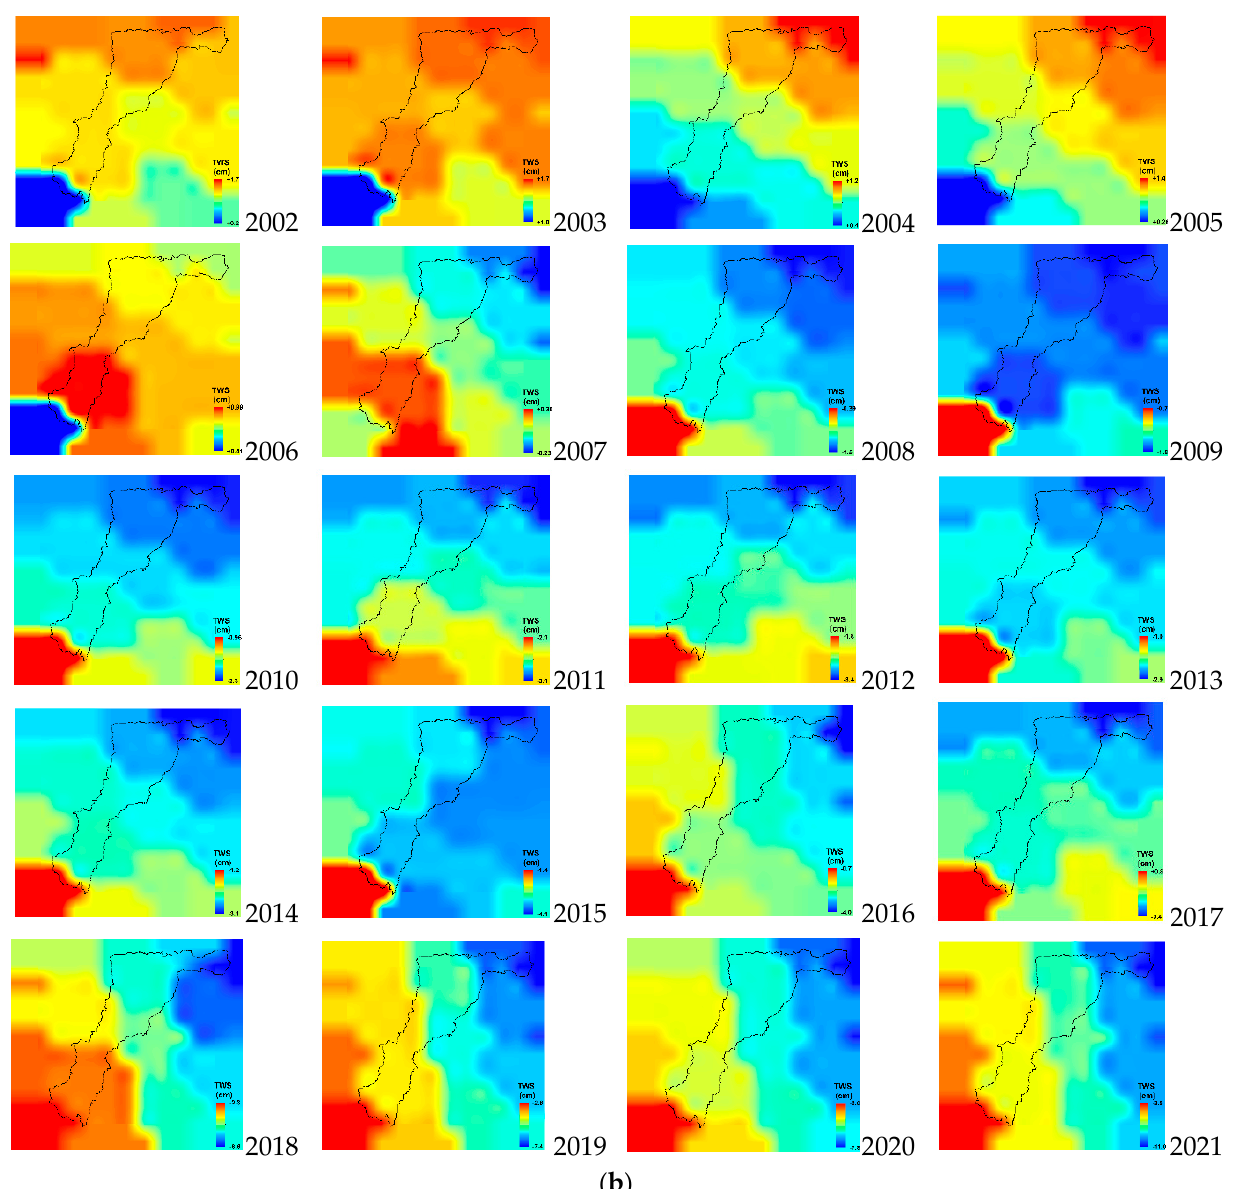
Figure 6. ( a ). Spatiotemporal variations in GRACE-derived ∆ TWS trend for the study area derived from mascon CSR solutions. ( b ). Spatial variations in the average GRACE-derived TWS values for the study area derived from mascon CSR solutions between 2002 and 2021.